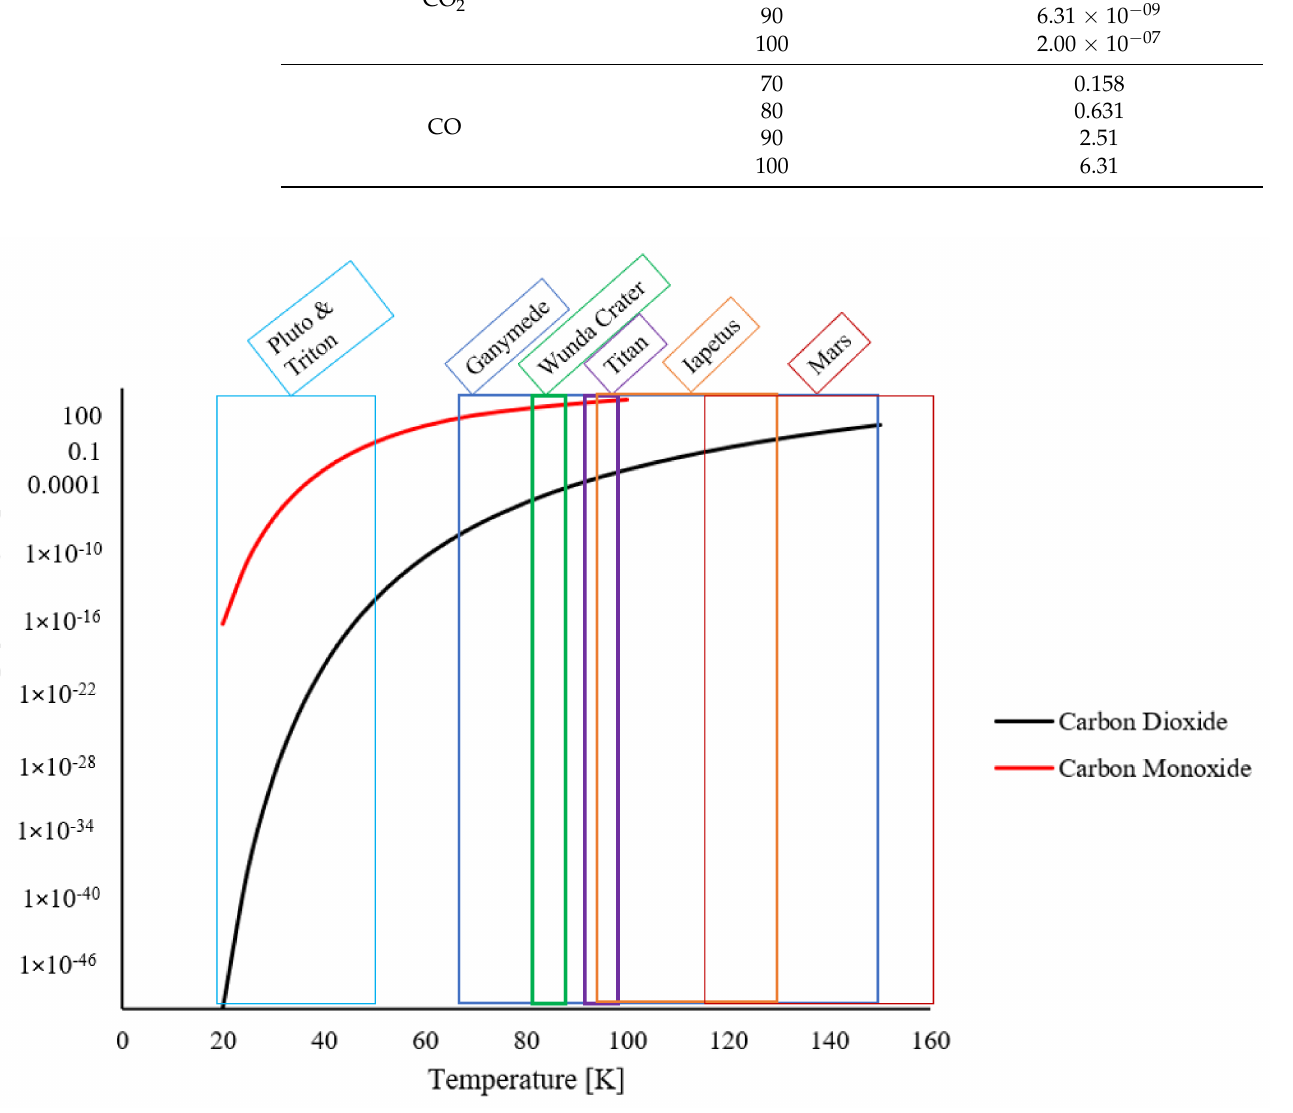
Figure 4. Sublimation rate curves for CO and CO 2 . Colored bars represent the temperature ranges of different icy satellites and Mars. Note that CO 2 is negligible at temperatures < 60 K in terms of thick deposits, such that it is not a viable ice source at Pluto and